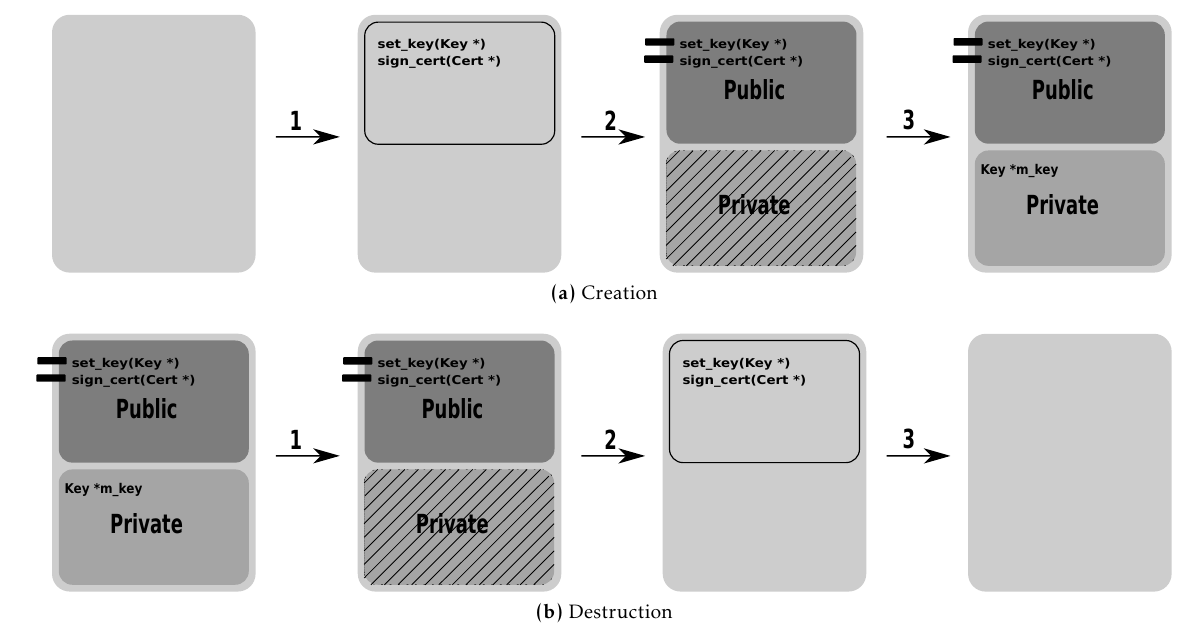
Figure 3. The life cycle of a protected compartment from creation (3a) to destruction